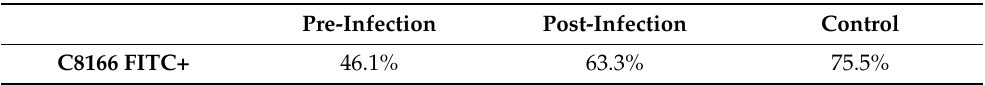
Table 7. Percentage of FITC+ cells treated with FITC-CS/hsDNA particles. C8166 cells were treated for 4 h before or after a single cycle of infection with HIV-1. Pre-Infection Post-Infection